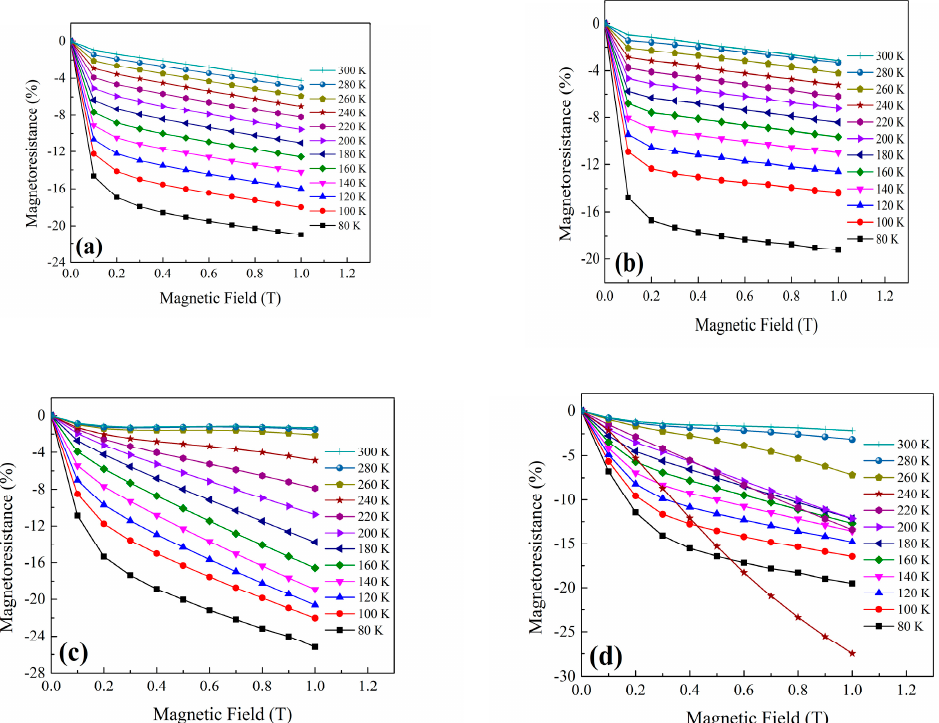
Figure 6. MR as a function of external applied magnetic field curves from 80–300 K for ( a ) LSSG, ( b ) LSSS, ( c ) NSSG, and ( d ) NSSS.